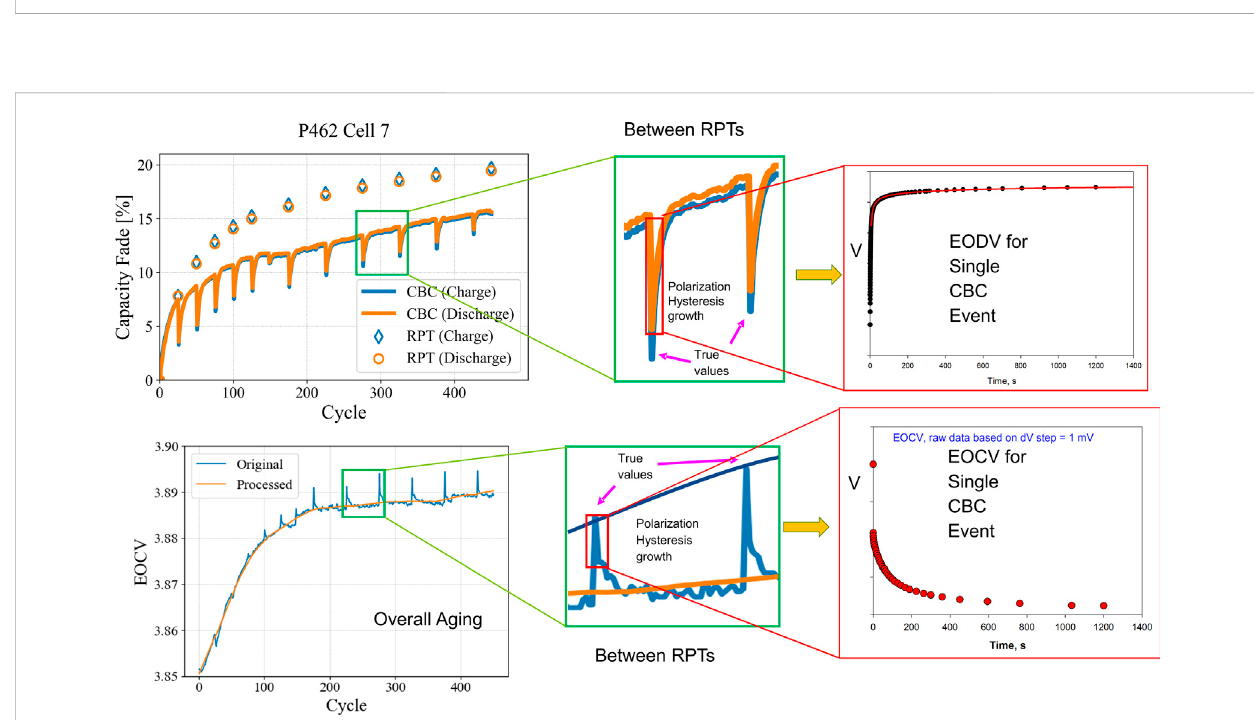
RPT (C/20) and CBC (C/2) data differ due to how polarization affects accessible capacity. Pink curves represent the trendlines for CBC data just following the RPTs, effectively removing polarization hysteresis effects between RPT conditions. Panel (A) shows cell 4 which was charged at a 6C rate